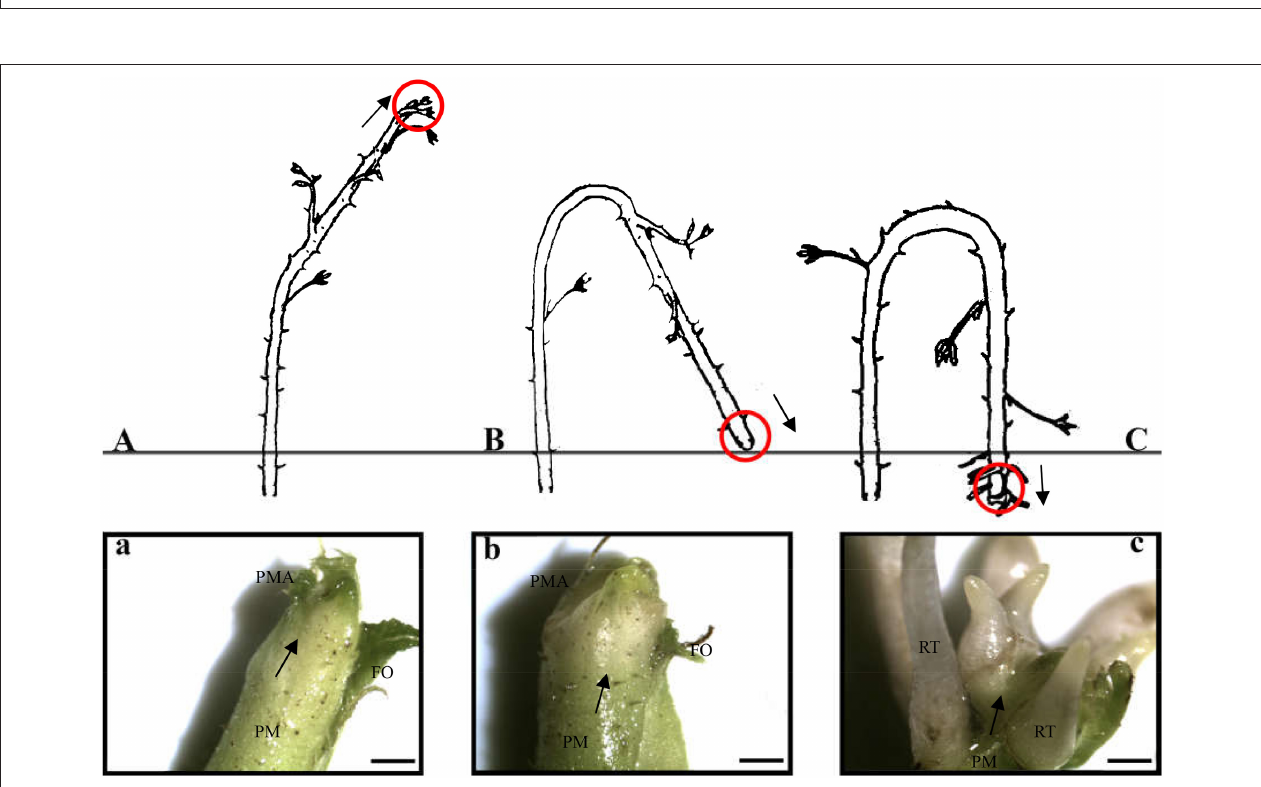
FIGURE 2 | Three rooting developmental stages of Rubus spp. stem apex (modified from Heslop-Harrison, 1959. Panels (a–c) are enlarged views of the parts circled in red in panels (A–C) , respectively. (A,a) SAP1, foliage on the tapering apex remains active; (B,b) SAP2, foliage on the apex withers, apex becomes blunt and its diameter increased dramatically; (C,c) SAP3, the apex becomes chlorotic and short roots began to form. Black arrows in above panels show axis orientations. PM, primocane; PMA, primocane apex; FO, foliage; RT, root. Scale bars in a, b, and c = 2.0 mm.